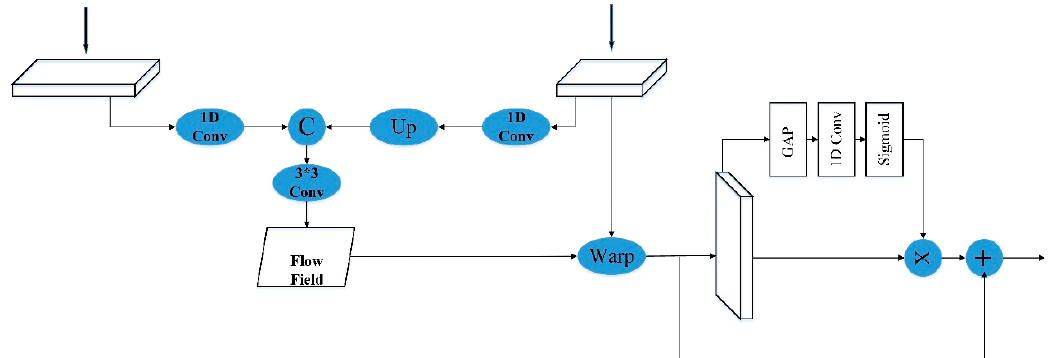
Figure 4. The up-sampling structure, composed of a low alignment module (FAM) combined with an attention module. Each black box represents a feature map.